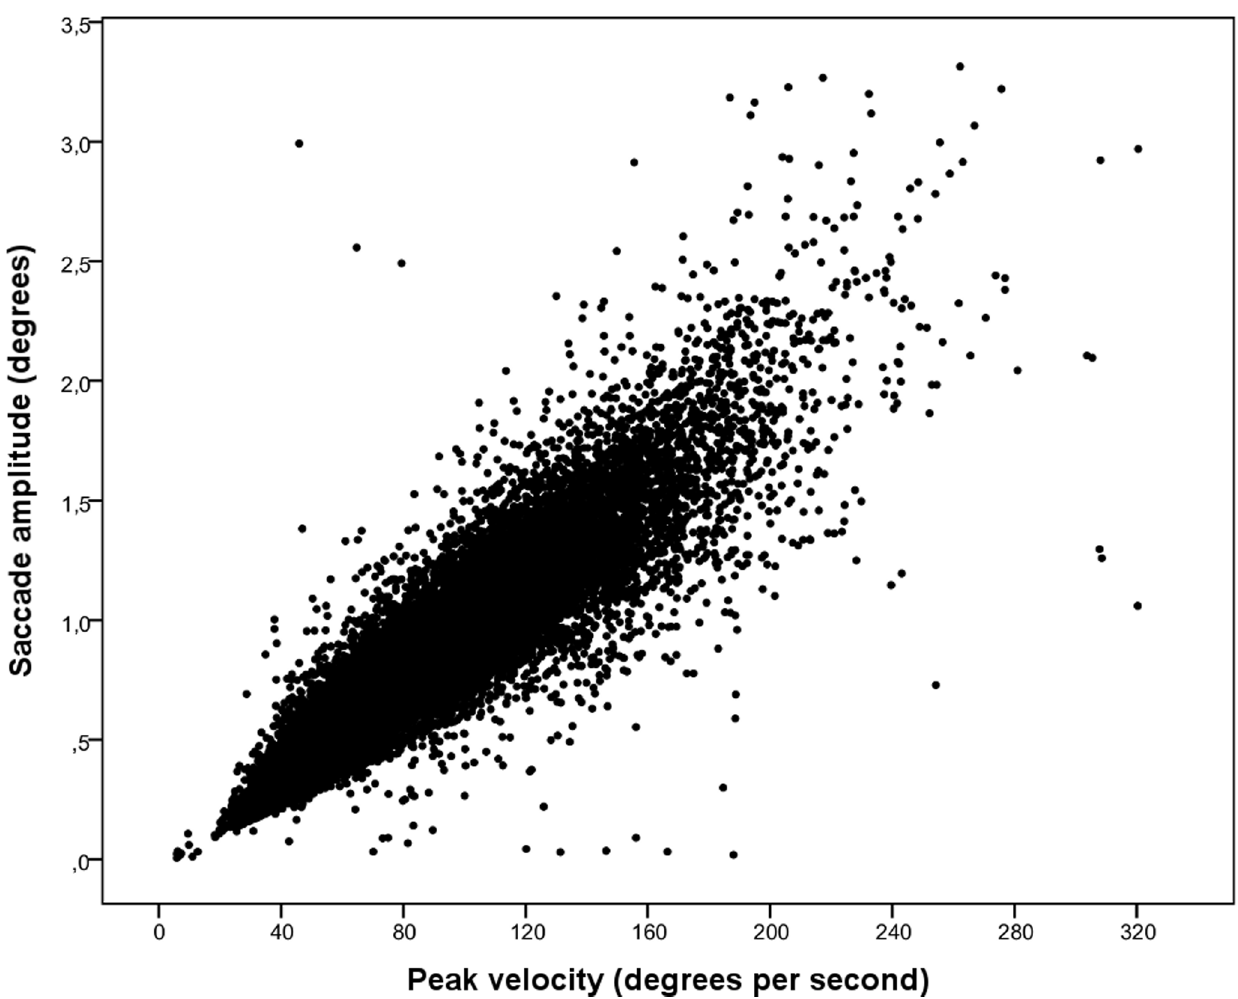
Figure 2. Saccade amplitudes as a function of peak velocities.